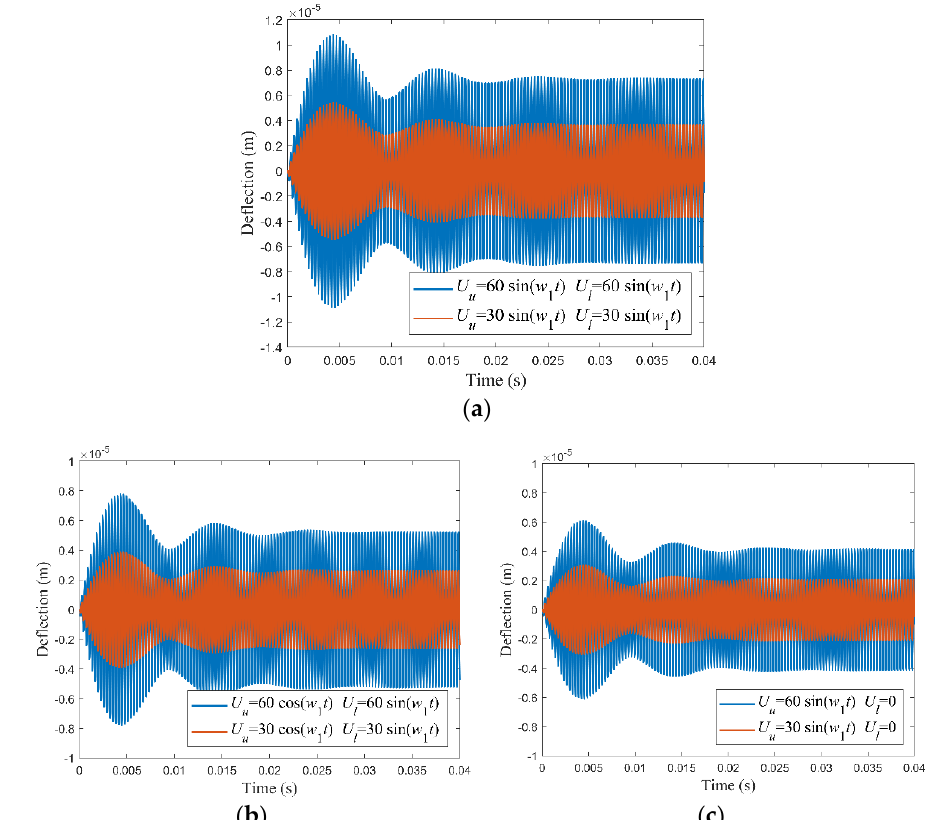
Figure 12. Transient analysis of a simply supported (SSSS) PFGP when the upper and lower